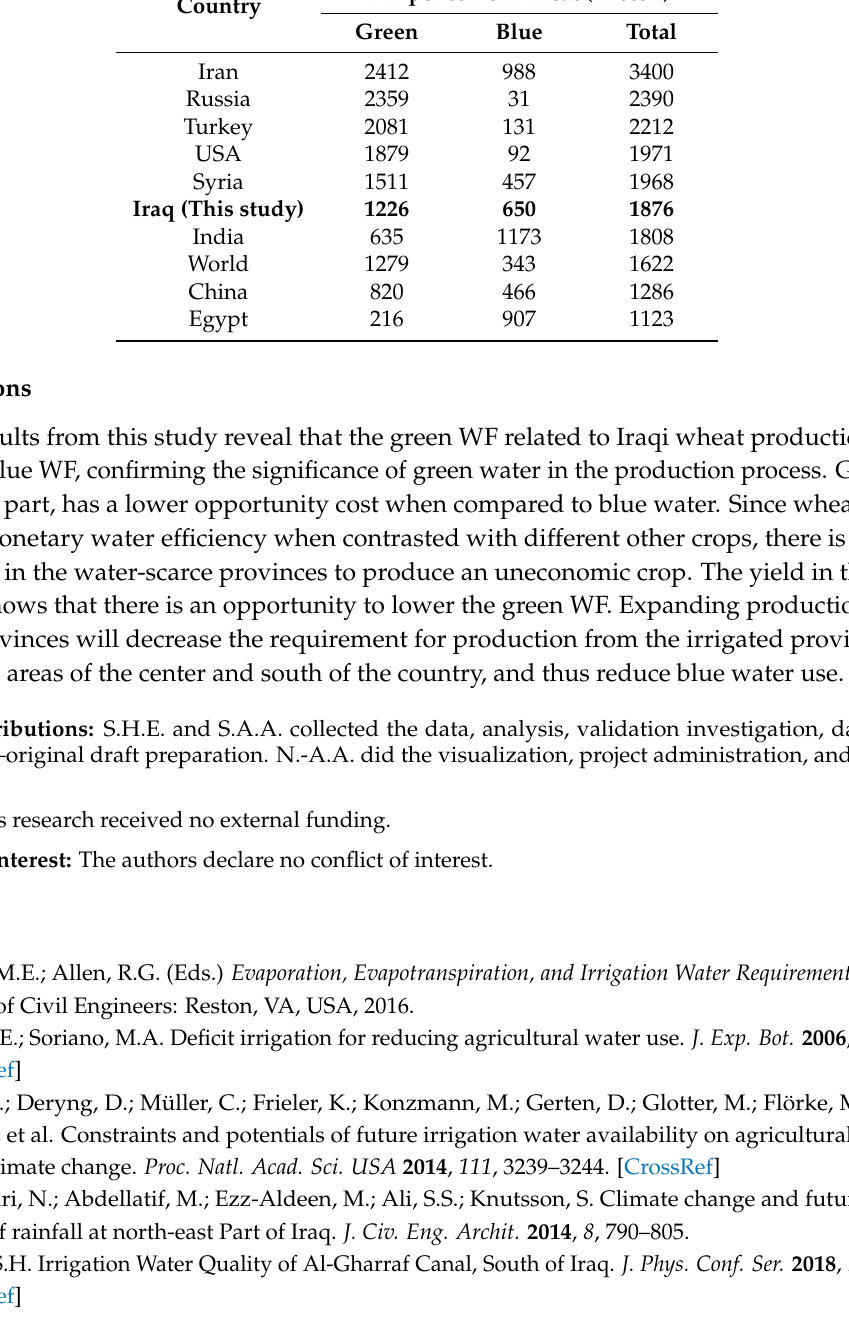
Table 4. Comparison of the results of this study with the WF values of some countries in the world [37]. WF per ton of Wheat (m 3 /ton) Country Green Blue Total Iran 2412 988 3400 Russia 2359 31 2390 Turkey 2081 131 2212 USA 1879 92 1971 Syria 1511 Iraq (This study) 650 1876 India World 1279 343 1622 China 820